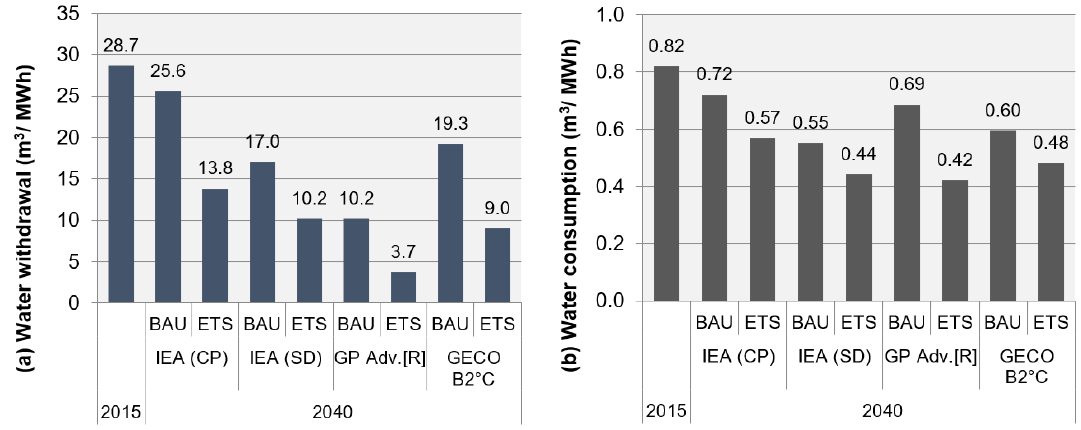
Figure 5. Average global freshwater intensities for water withdrawal ( a ) and consumption ( b ) for electricity generation (m 3 / MWh) for 2015 and the four energy scenarios in combination with changes in the power plant type and cooling technologies (BAU and ETS scenarios) in 2040. (Source: own calculation based on the data from [39–41]).